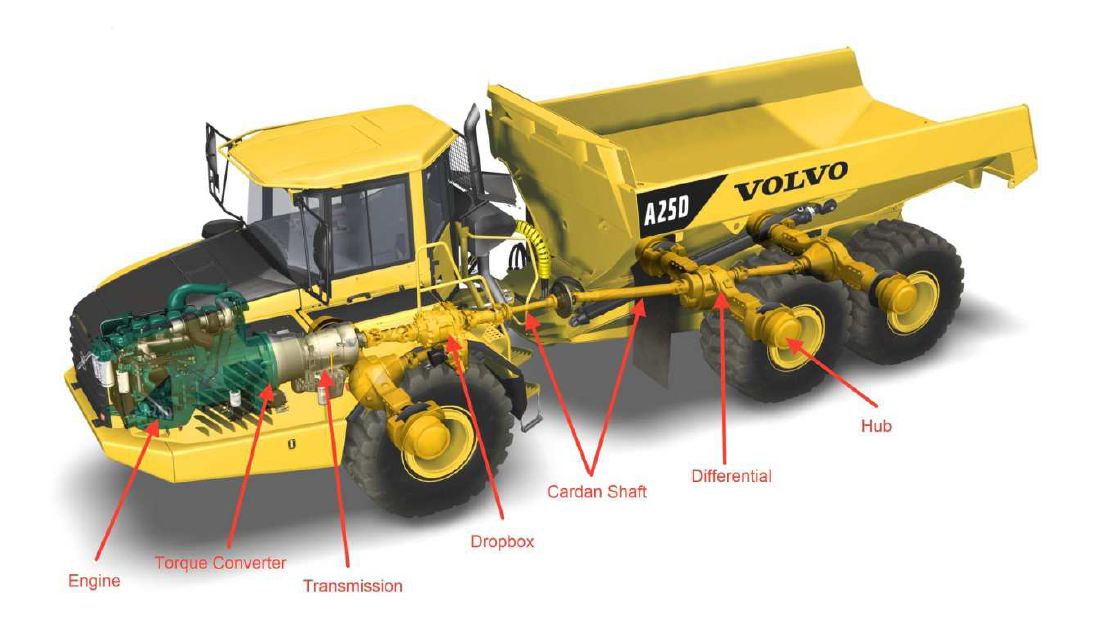
Figure 1. An articulated hauler